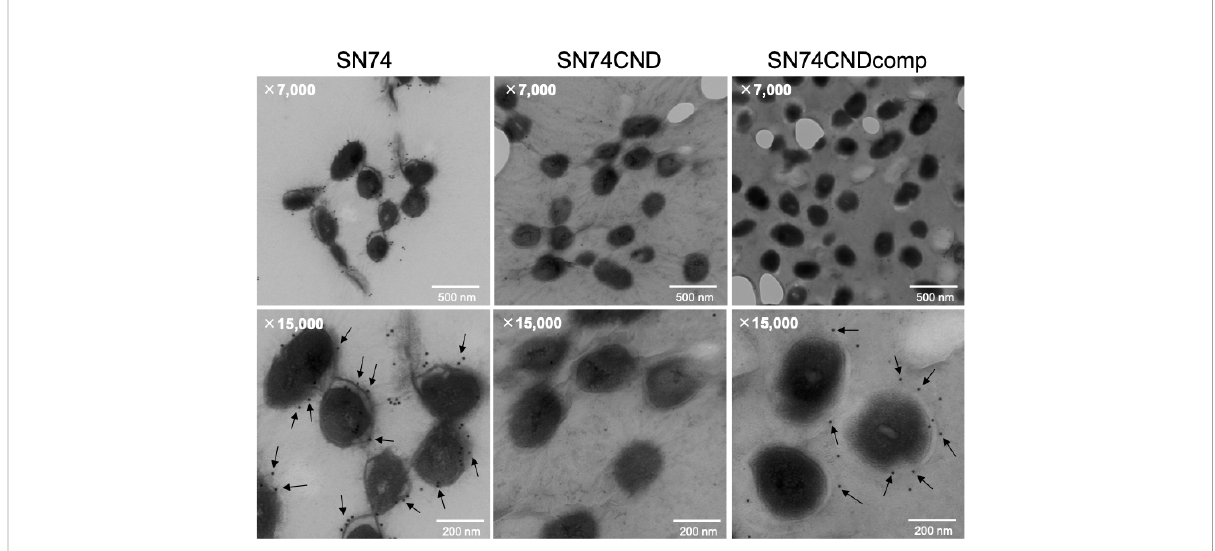
FIGURE 4 Immunogold transmission electron microscopic images of S. mutans strains SN74, SN74CND, and SN74CNDcomp. Scale bar of the upper image, 500 nm; scale bar of the lower image, 200 nm; magni fi cation of the upper image, ×7,000; magni fi cation of the lower image, ×15,000. The arrows indicate gold colloidal particles.